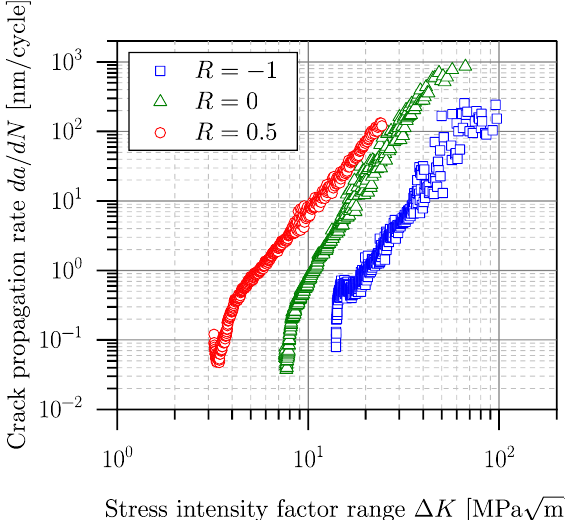
Figure 7. Crack propagation curves for investigated stress